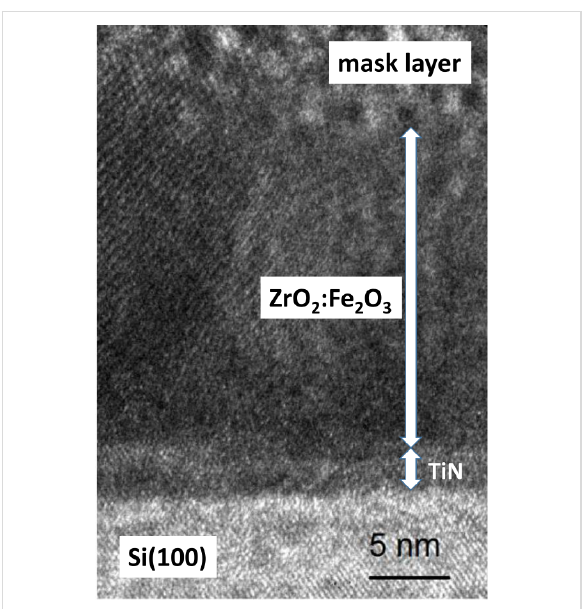
Figure 5: TEM image of a ZrO 2 /Fe 2 O 3 sample with cycle ratio 10:3 on TiN. 231 atomic layer deposition cycles were deposited.